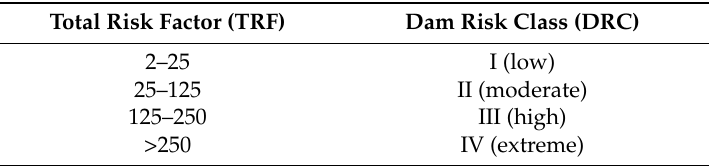
Table 6. Definition of dam risk class (from